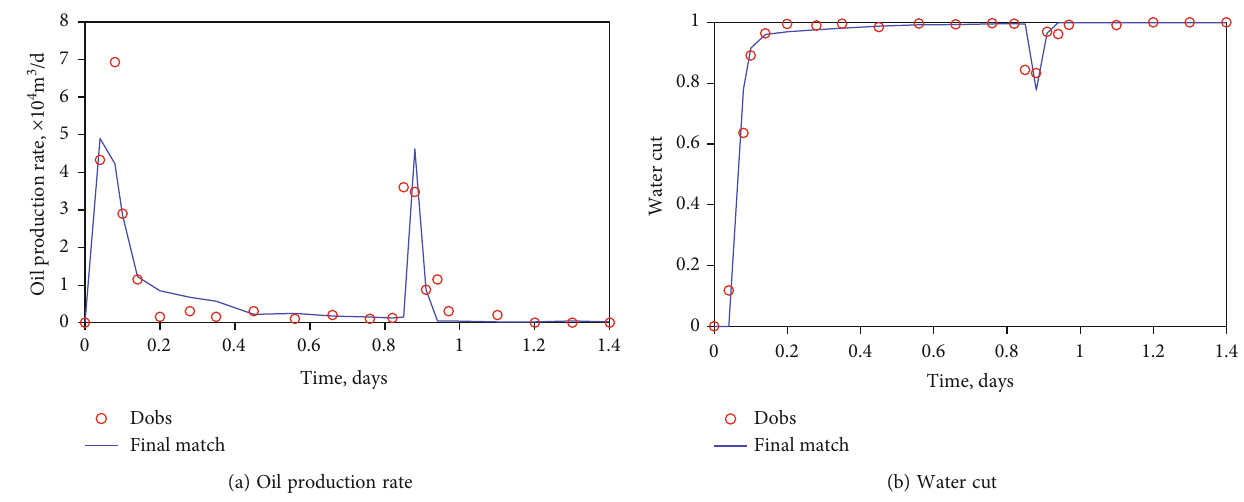
Figure 10: Oil production rate and water cut change after SMG pro fi le control.